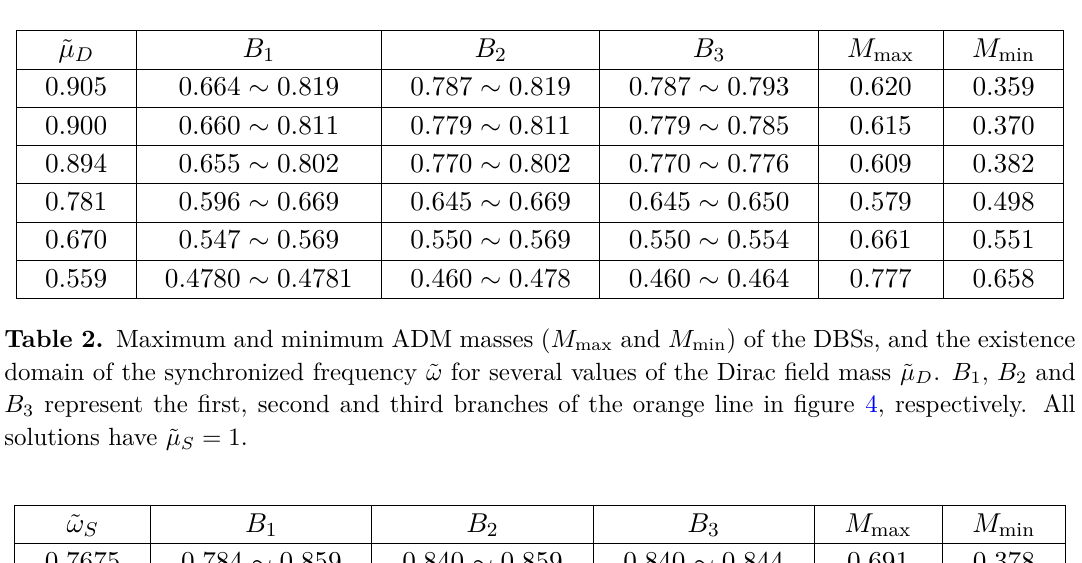
Table 1. The existence domain of the synchronized frequency ˜ ω for several values of the Dirac field mass ˜ µ D . All solutions have ˜ µ S = 1 .